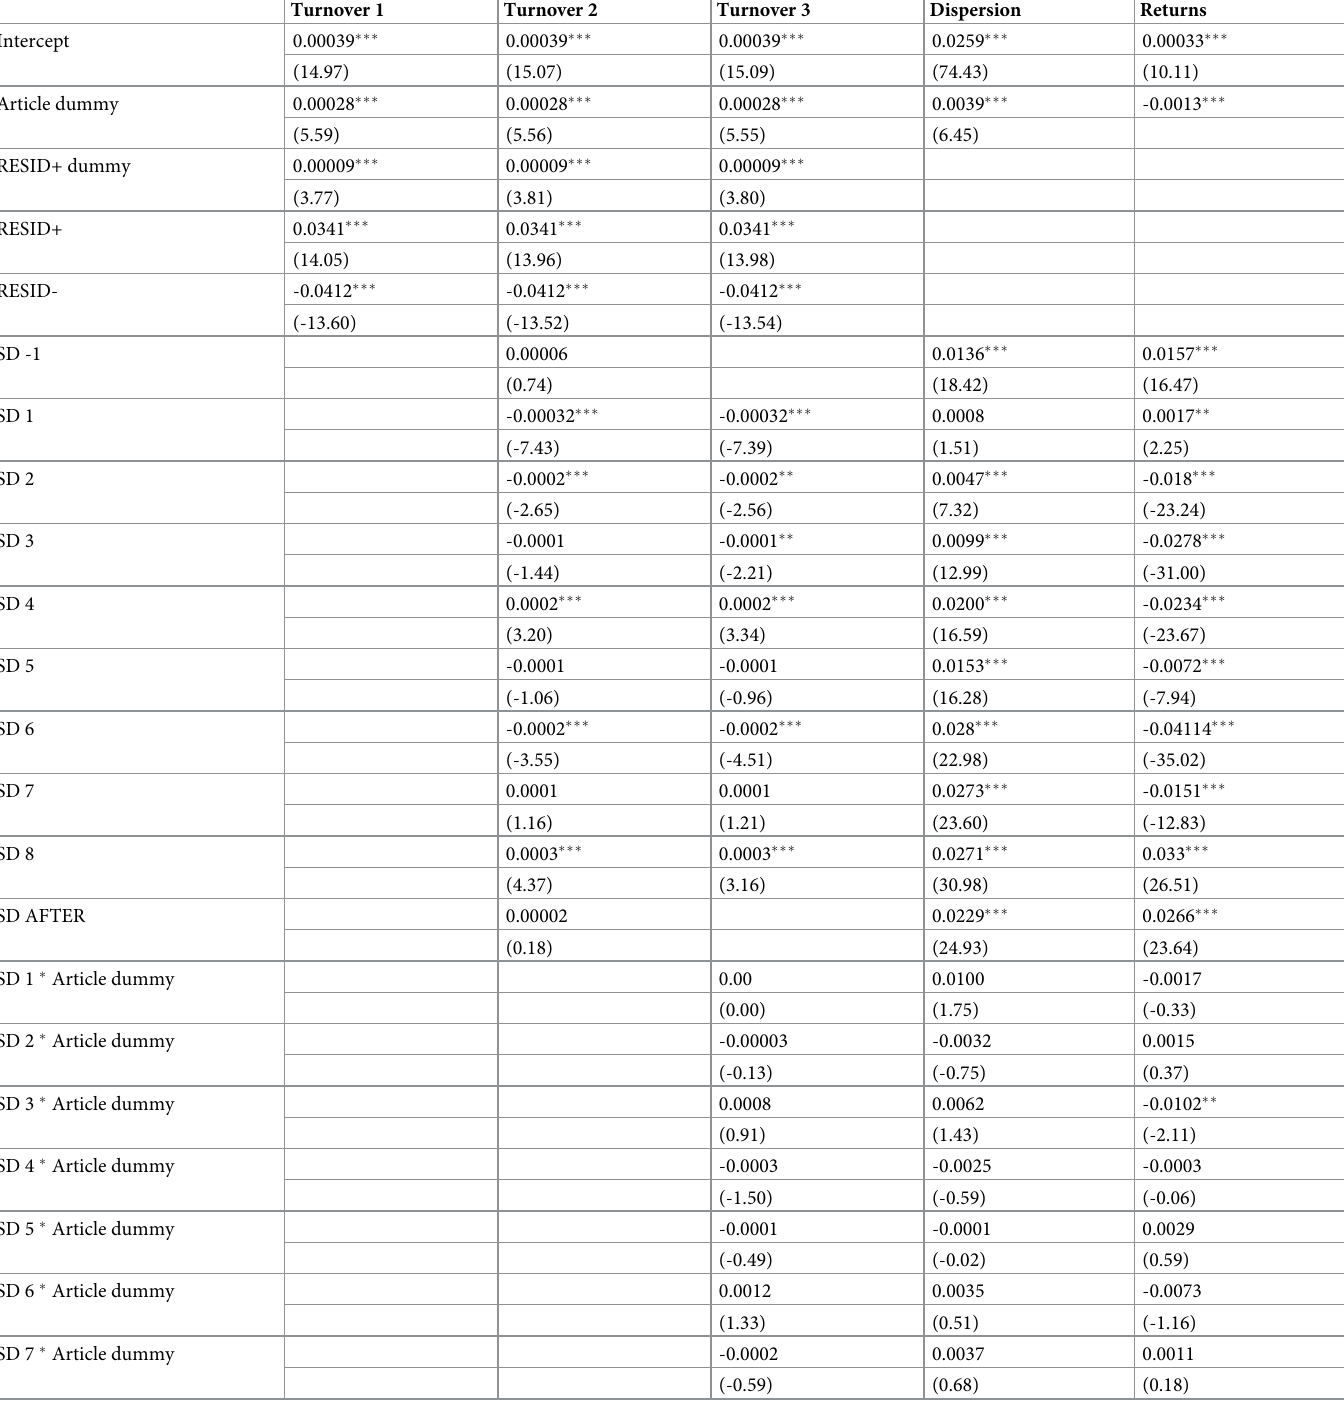
Table 3. Effect of strike on turnover, dispersion, and returns. Coefficients and t -statistics (in parentheses) from an OLS regression with daily turnover, dispersion, and returns as the dependent variables and a dummy variable that indicates whether WSJ wrote about that firm on that day (Article dummy), the positve (RESID+) and nega- tive (RESID-) residuals from a market-model regression, a dummy variable for when the residual was positive (RESID+ dummy), day-of-the-strike dummies (SD -1, SD1, SD2, ... ), and interaction terms as independent variables. Dummy variables for day-of-the-week and for each firm are also included. Standard errors are clustered by